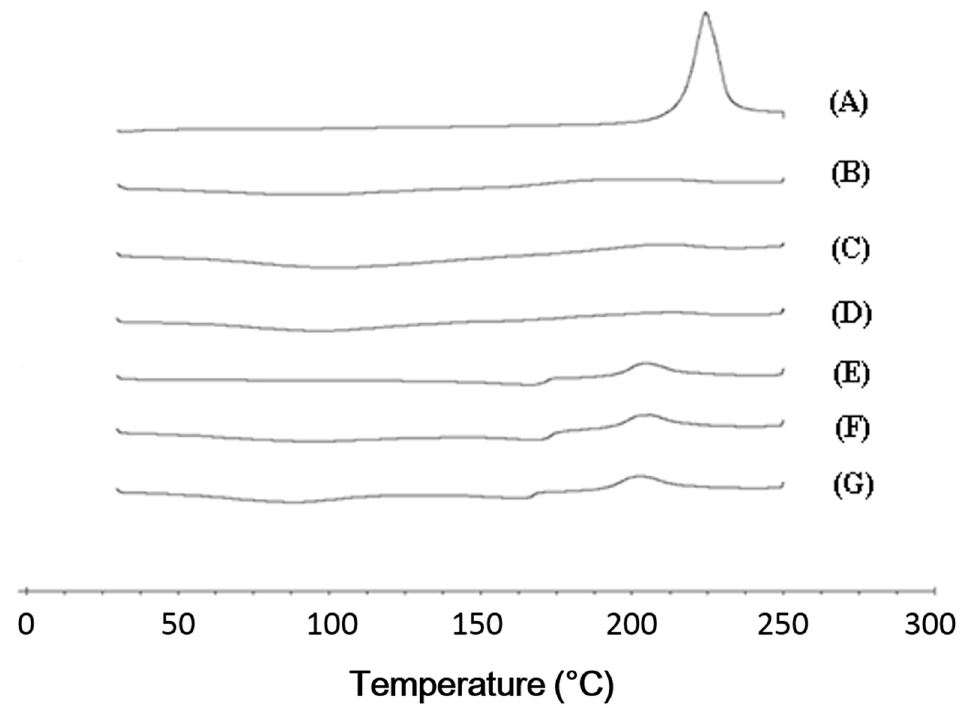
Figure 4. The DSC curves of cefdinir ( A ), CSD1 ( B ), CSD2 ( C ), CSD3 ( D ), physical mixture of cefdinir and HPMC ( E ), physical mixture of cefdinir and CMC-Na ( F ), and physical mixture of cefdinir and PVP K30 ( G ).